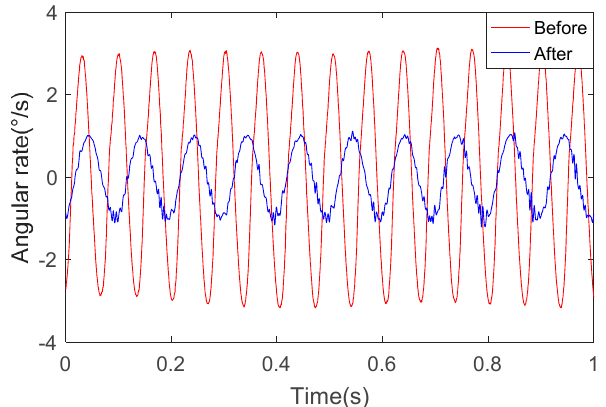
20 of 23 Figure 15. Angular rate in the direction of the roll axis.